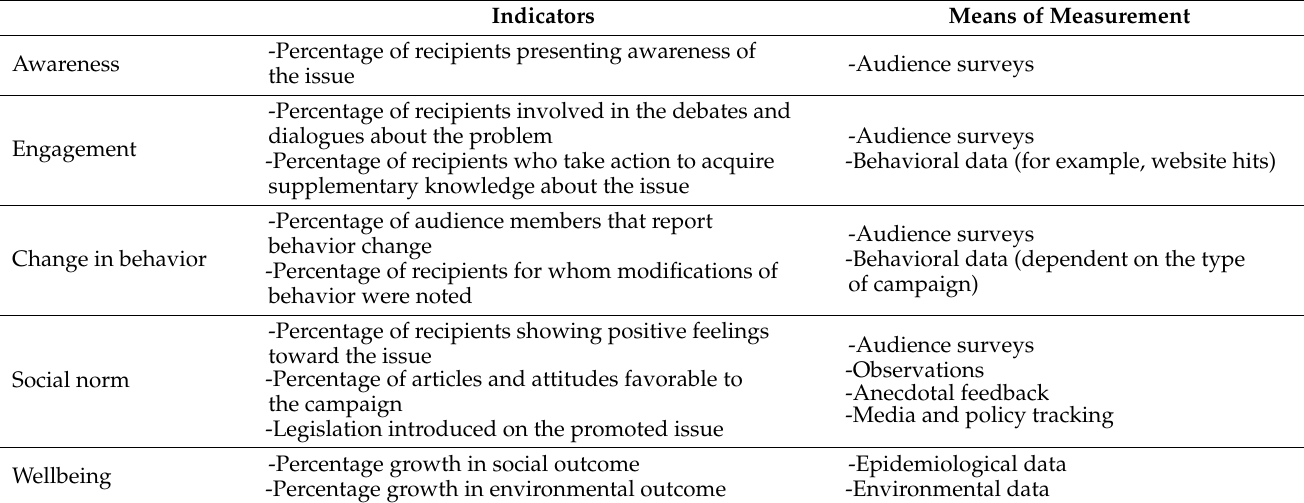
Table 1. Indicators and measures used in the evaluation of a communication campaign’s message effectiveness (source: